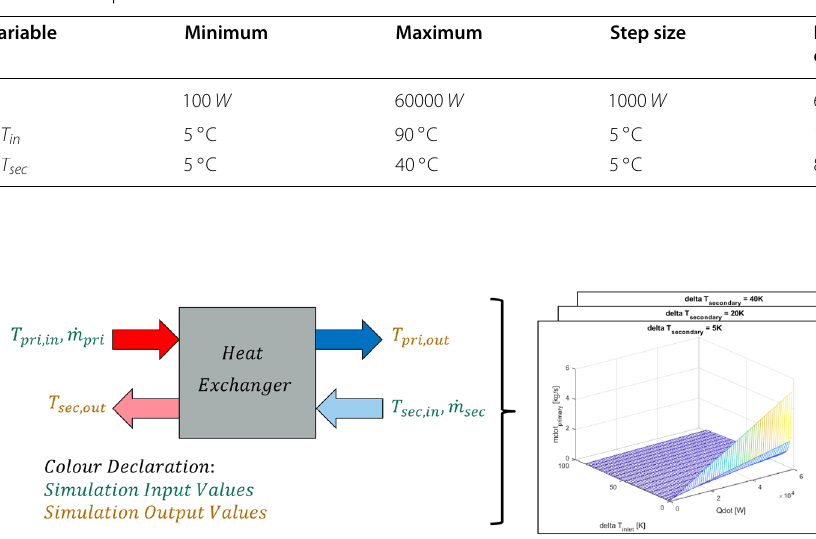
Fig. 5 Schematic of the procedure for determining the CF of the HEx [own